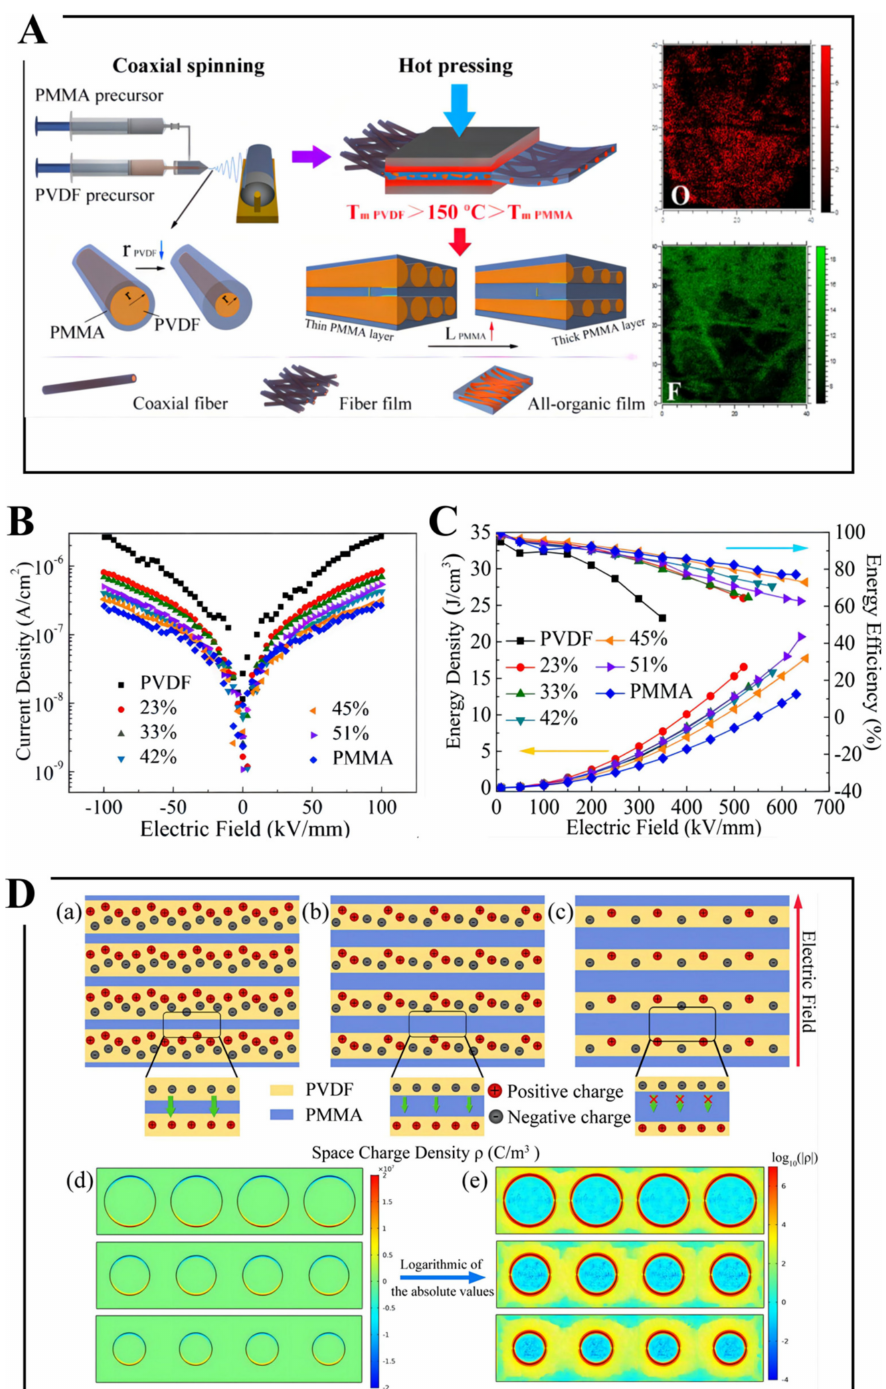
Figure 11. ( A ) Schematic illustration of the fabrication process of PMMA/PVDF all-organic films via coaxial spinning and hot pressing, and time-of-flight secondary ion mass spectrometry (ToF-SIMS) elemental maps of O and F of a 51% PMMA/PVDF all-organic film. ( B ) Current density, ( C ) energy density and energy efficiency of PMMA/PVDF all-organic films with varying PMMA content. ( D ) Schematic of charge migration in local micro-interfaces of a ferroconcrete-like struc- ture. PMMA/PVDF all-organic film featuring ( a ) coarse, ( b ) intermediate, and ( c ) fine PVDF fibers. ( d ) Calculated profile of the space–charge density profile in a localized area of the PMMA/PVDF organic film and ( e ) logarithm of the absolute value of the space–charge density in a local area. Adapted with permission from [46], Copyright © 2022 American Chemical